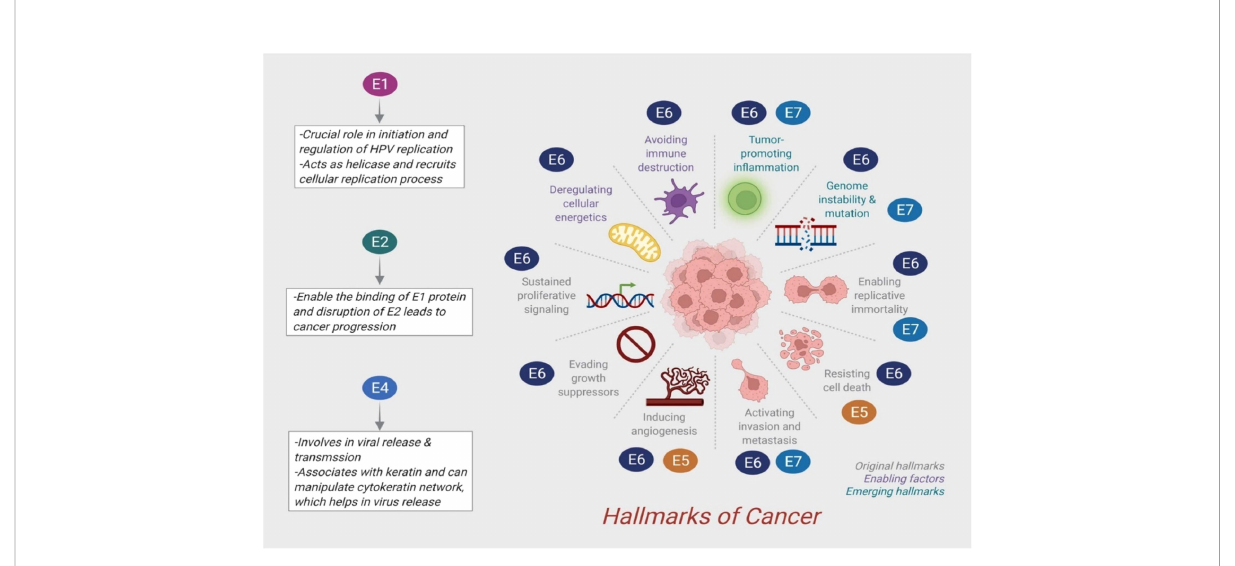
FIGURE 2 Role of early oncoprotein for cancer progression. Adapted with open access permission from